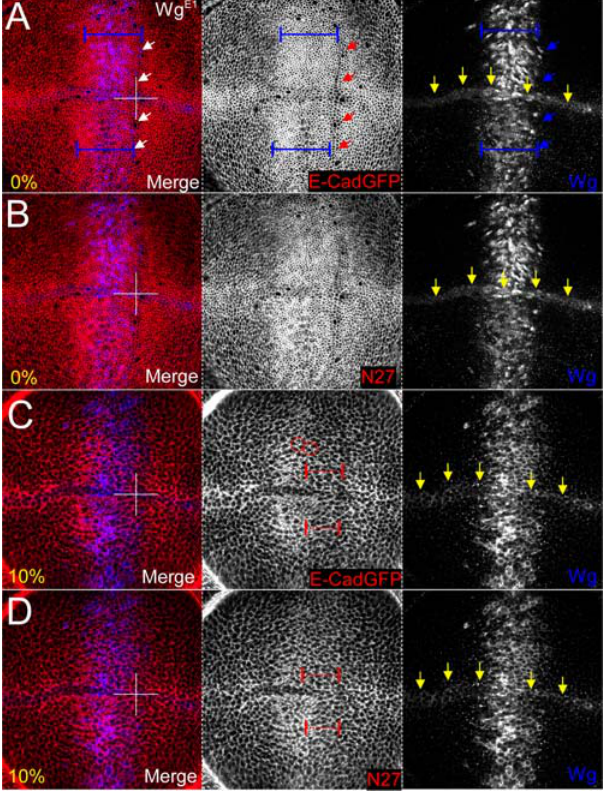
Figure 6. Expression (0% and 10%) of apicobasal polarity markers upon overexpression of UASWg E1 under dppGAL4 . (A, B) At 0%, Wingless signalling changes neither the levels nor the subcellular distribution of apicobasal polarity markers, including E- Cadherin and Armadillo, apically where they are normally situated. The endogenous Wingless (blue channel) at the D/V boundary is indicated by yellow arrows. Both E-Cadherin-GFP expressed ubiquitously (A, E- CadGFP, red channel) and endogenous Armadillo (B, N27, red channel) are stable in the AJ in spite of very high levels of overexpressed Wingless. The A/P boundary is clearly demarcated by aligned cells (A, white, red or blue arrowheads), and the cells seem more densely packed or apically constricted within the overexpression domain (yellow dimension bars). (C, D) At 10%, Wingless signalling induces accumulation of Armadillo puncta subapically, corresponding to a change in E-cadherin levels. The endogenous Wingless (blue) channel at the D/V boundary is indicated by yellow arrows. (C) and (D) represent the same wing disc at the same basal position to allow comparison of protein localisation. (C) E-Cadherin accumulates in puncta (red circles) but also appears to be depleted from the basolateral membranes (yellow arrows). (D) In contrast, Armadillo accumulates in many puncta, of which many correspond to E-Cadherin dots, but does not appear depleted from the basolateral membrane (compare expression in domain delineated by the yellow dimension bars in A and B).